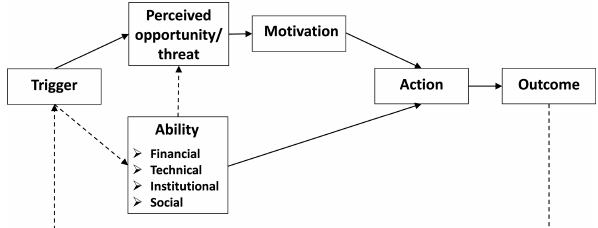
Figure 1. The base model MOTA framework (adapted from Phi et al., 2015, and Quan et al., 2019), showing the relationships between the trigger, motivation and ability elements, as well as the action and outcome. The solid arrows indicate the influence of one element on another, and the dashed arrows indicate a potential